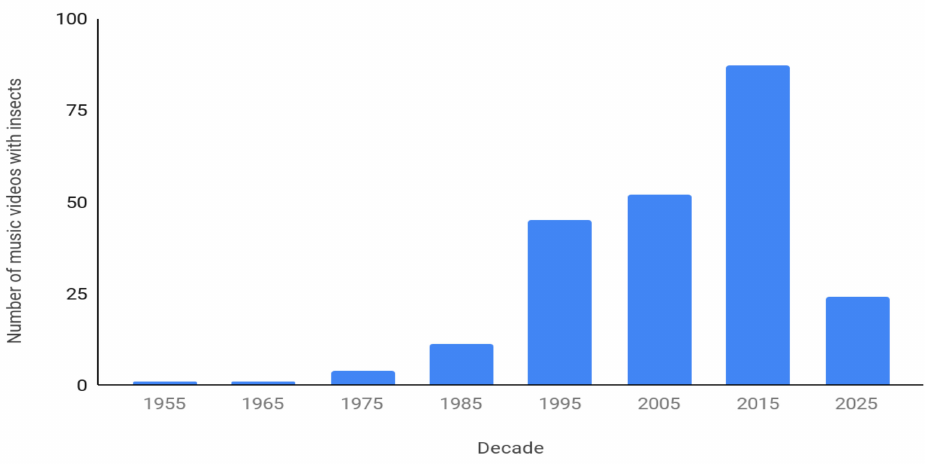
Figure 2. A histogram demonstrating the appearance of insects in music videos over time. The data are organized by decade from 1950 to 1959, and so on. The last bar only covers 2020 and part of